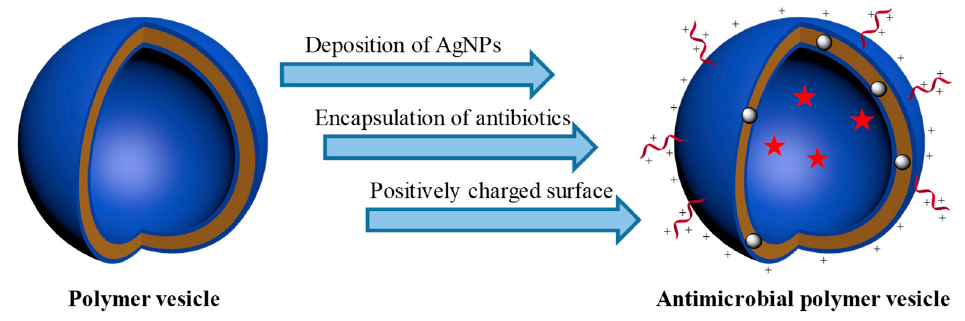
Scheme 1. Design strategies of antimicrobial polymer vesicles.